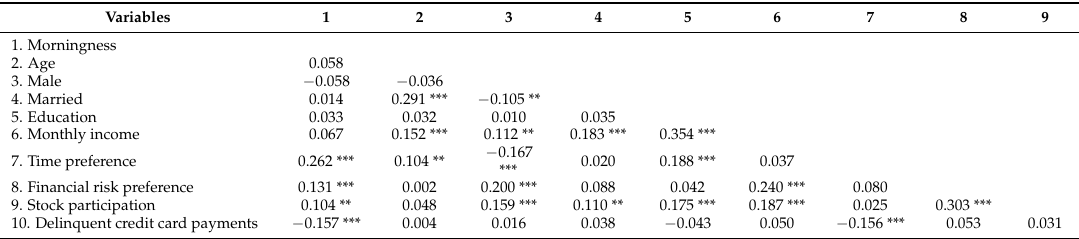
Table 2. Pearson’s correlation coefficients for key study